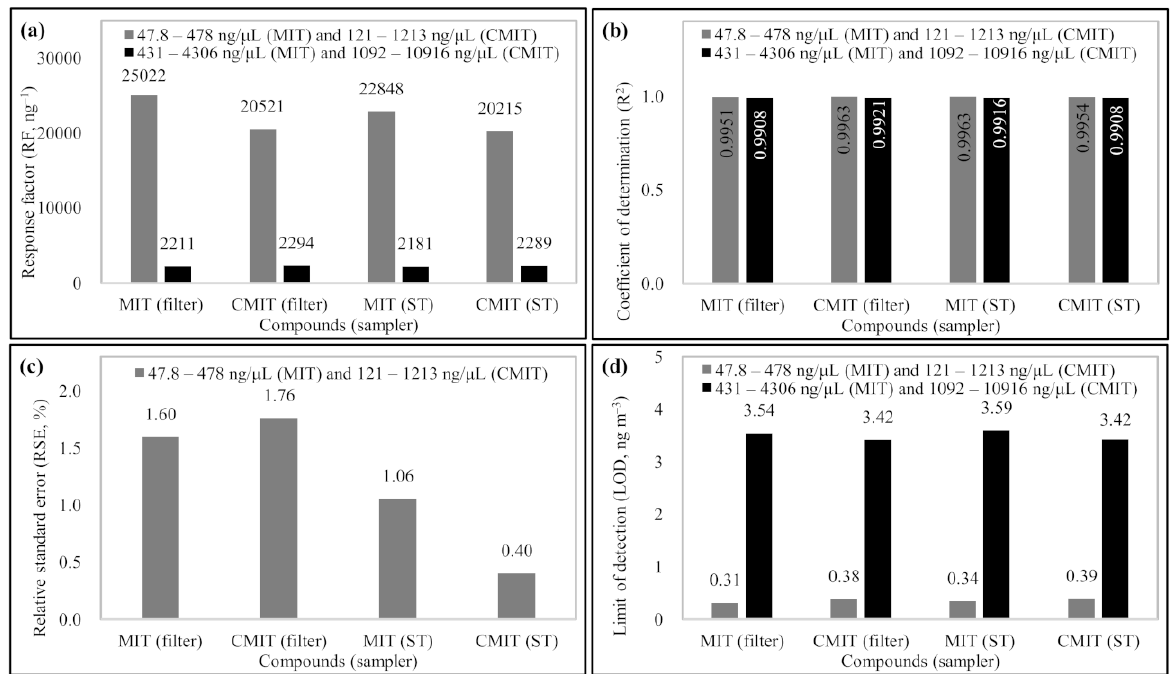
Figure 2. Basic calibration and QA results using working standards: ( a ) response factor (RF, ng − 1 ), ( b ) coefficient of determination (R 2 ), ( c ) relative standard error (RSE, %), and ( d ) limit of detection (LOD, ng m − 3